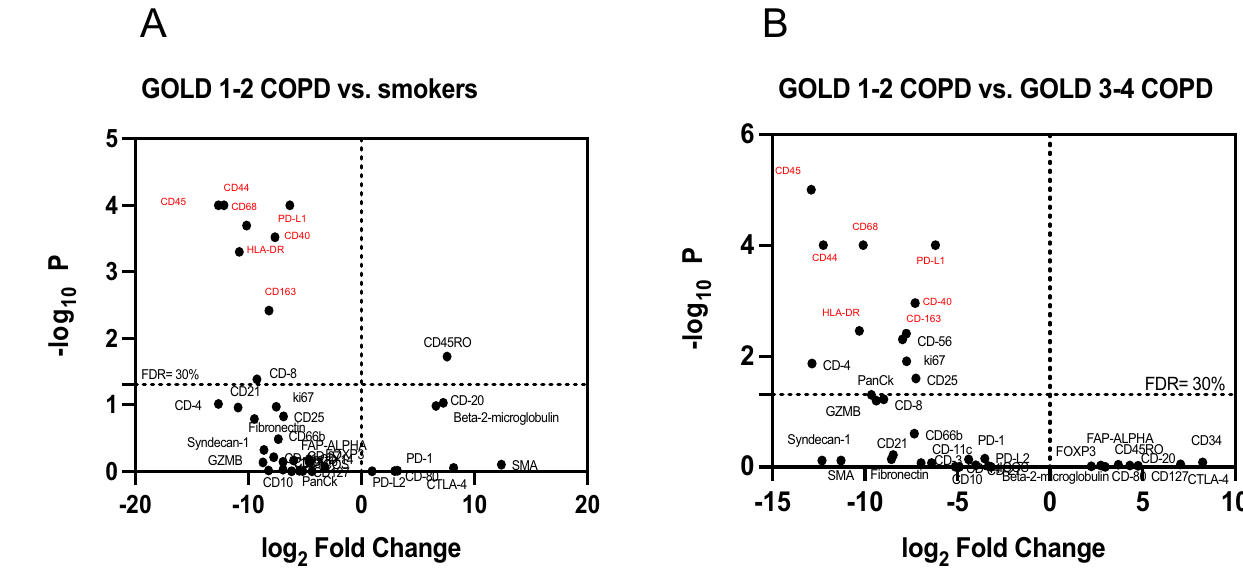
Figure 2. Top protein targets identified with spatial profiling: Volcano Plot showing the proteins above a false discovery rate of 30% in peripheral lungs (across all the regions of interest) of smokers without COPD versus GOLD 1–2 COPD ( A ) and GOLD 1–2 COPD versus GOLD 3–4 COPD ( B ). The x-axis is the log2 fold change, whereas the y-axis is the log10 of the p-value. In red, the most significantly up-regulated proteins in GOLD 1–2 COPD patients versus smokers ( A ) and GOLD 3–4 COPD ( B